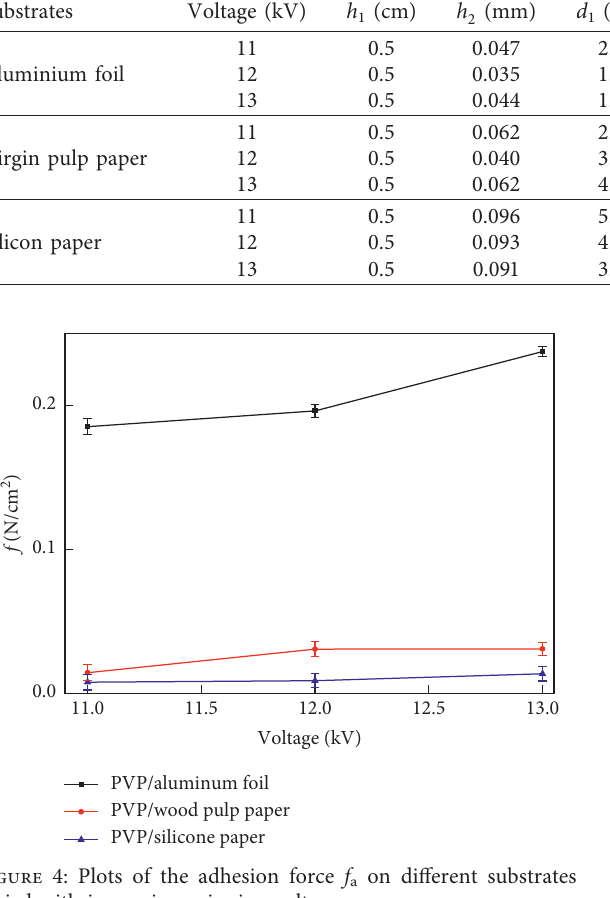
a on different substrates